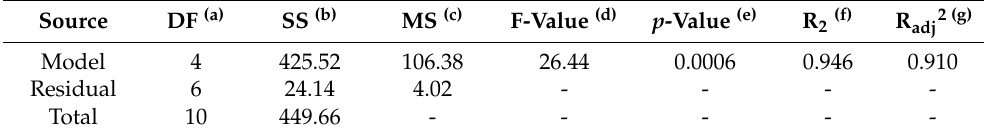
Table 4. ANOVA (statistical test) for the developed mathematical model Ŷ (x 1 ,x 2 ).